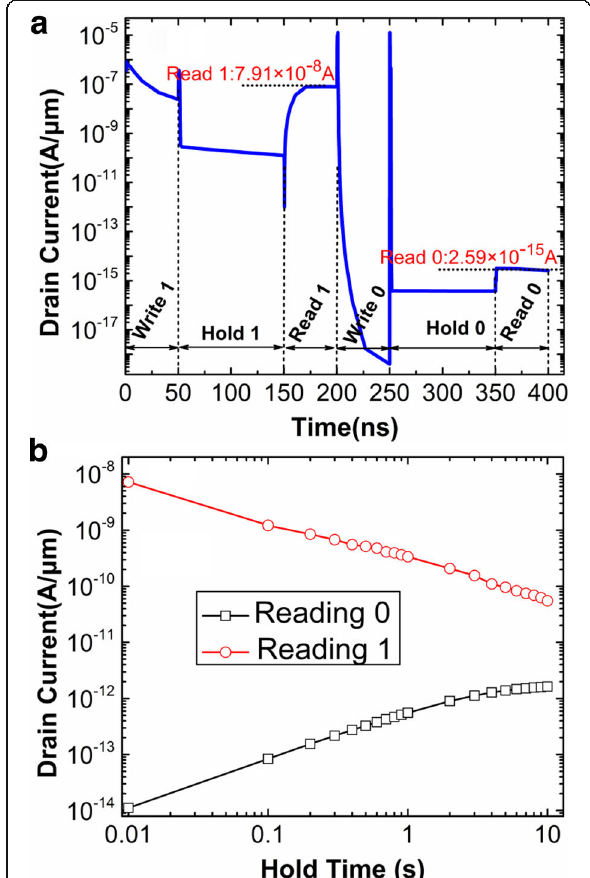
Fig. 9 a Transient drain currents in the sequence of the operation; b variation of reading current with the holding time. a The transient current of DGTFET DRAM cell during the writing, holding and reading operations. b The variations of reading “ 1 ” and reading “ 0 ” current with the different holing